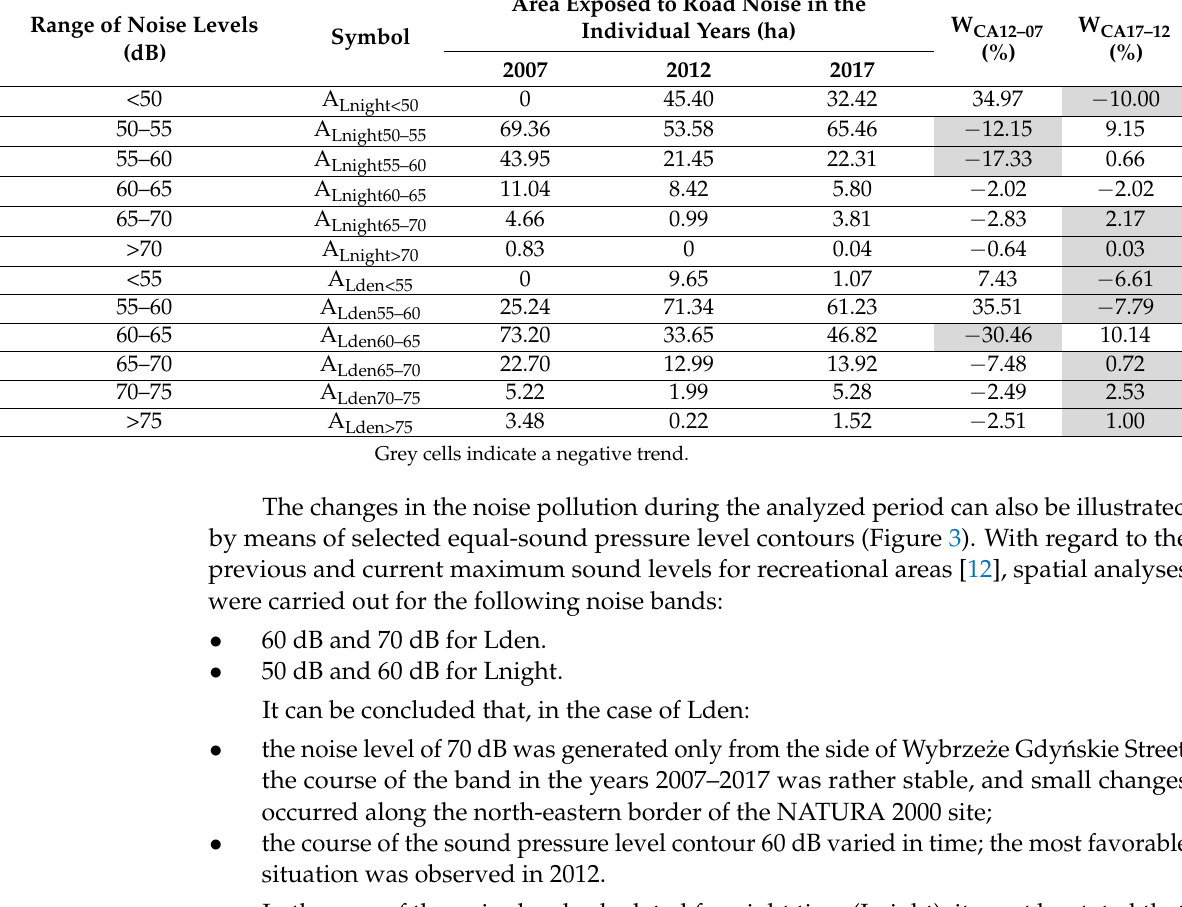
Table 2. Changes in the areas exposed to road noise according to the Lnight and Lden indicators in 2007, 2012 and 2017 in Biela´nski Forest NATURA 2000 (our own elaboration on the basis of maps of noise pollution in Warsaw). Range of Noise Indicator